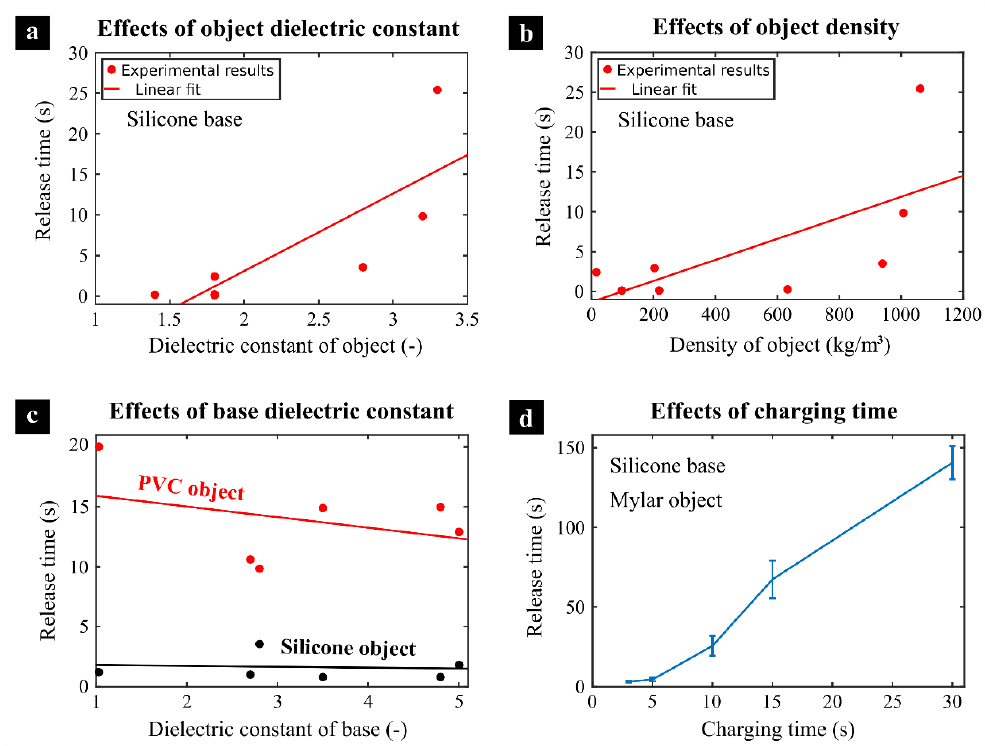
Figure 5. Detailed studies on the release time. ( a ) Effects of the object’s dielectric constant on the release time. Silicone base is used. ( b ) Effects of the object’s density on the release time. Silicone base is used. ( c ) Effects of base material’s dielectric constant on the release time of polyvinyl chloride (PVC) and silicone objects. ( d ) Effects of the charging time on the release time. Silicone base and Mylar material object are adopted in this comparison.